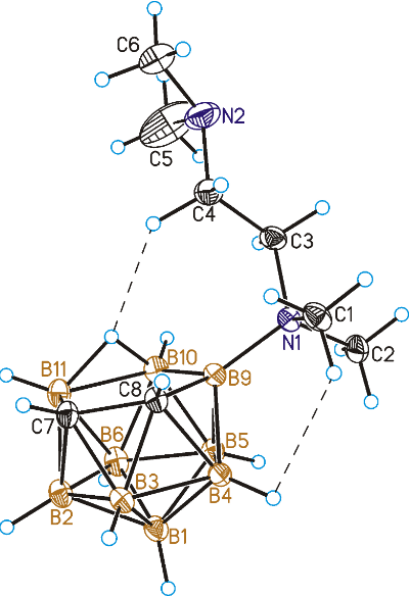
Figure 1. Molecular view of 9-Me 2 N(CH 2 ) 2 Me 2 N- nido -7,8-C 2 B 9 H 11 4 presented by thermal ellipsoids at 50% probability level. Shortened H4A . . . H12 and H4 . . . H1A contacts are shown by dashed lines. Further, we decided to use a more stable terminal nido -carboranyl alkyne with one ammonium center, 9-HC ≡ CCH 2 Me 2 N- nido -7,8-C 2 B 9 H 11 ( 5 ) [42]. The usage of this alkyne excluded the elimination of the propargyl fragment in compound 5 . Indeed, the reaction of acetylene 5 with azido-3 β -cholesterol 2 , under the same conditions as for compound 1 , produced the novel conjugate of nido -carboranyl cholesterol 6 with a zwitter-ionic character of its target molecule (Scheme